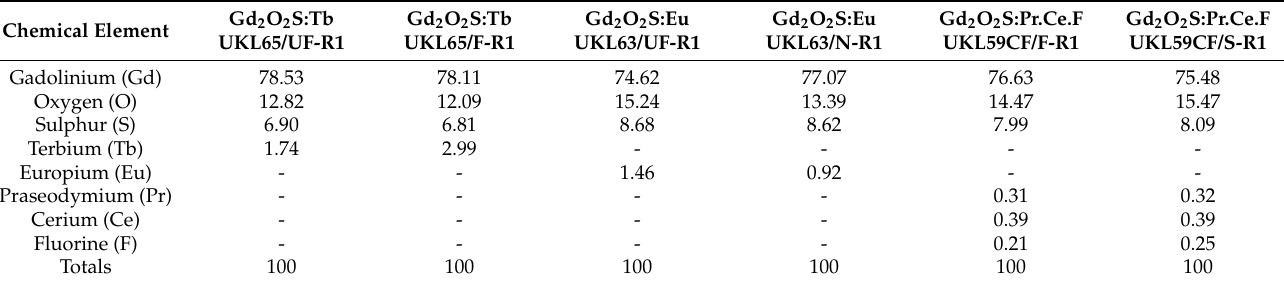
Table 1. Stoichiometric results for the examined grains.